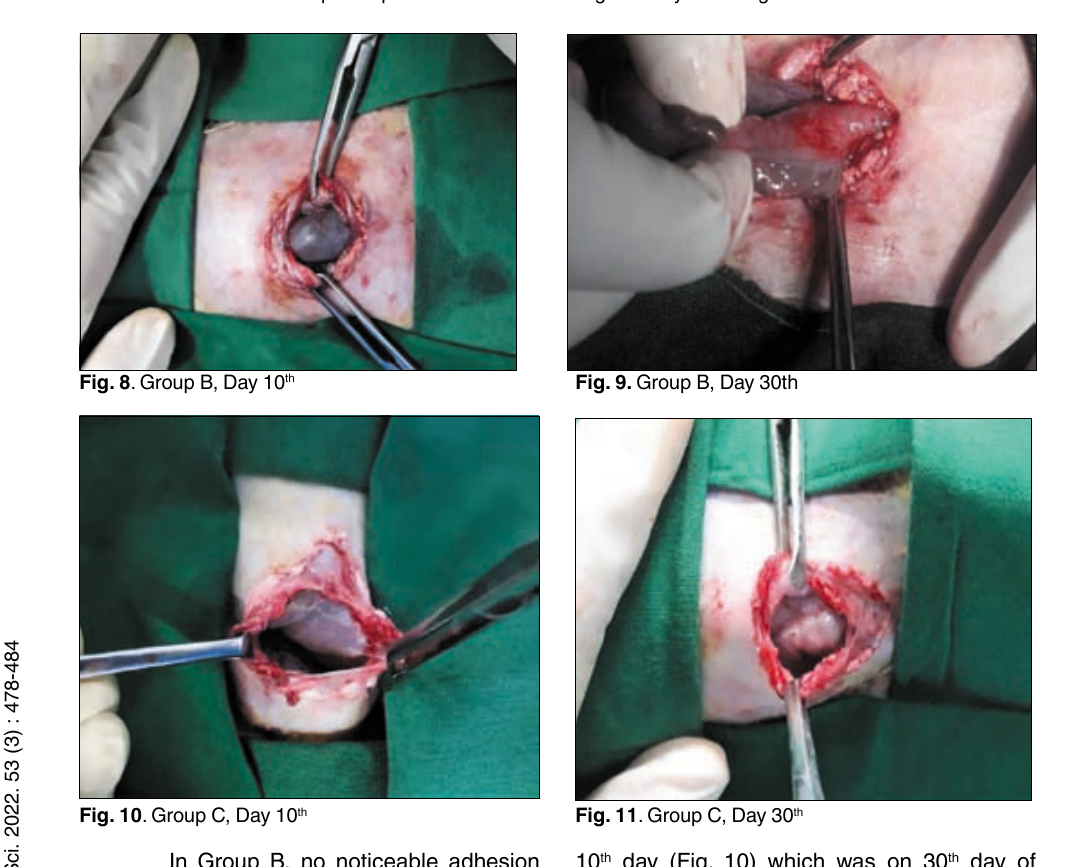
482 Pectin-honey hydrogel and olive-oil vitamin E in prevention of peritoneal adhesion.